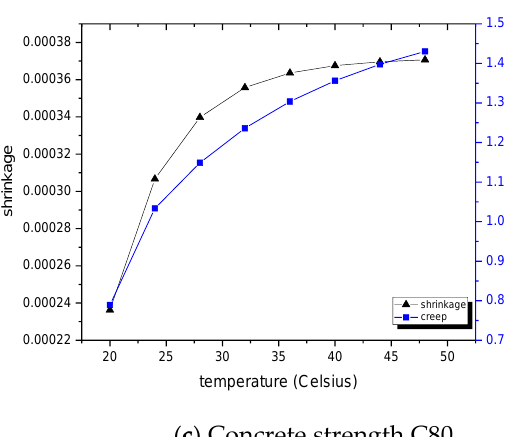
Figure 11. Effect of temperature on the time-dependent behaviour of prestressed concrete sleepers.